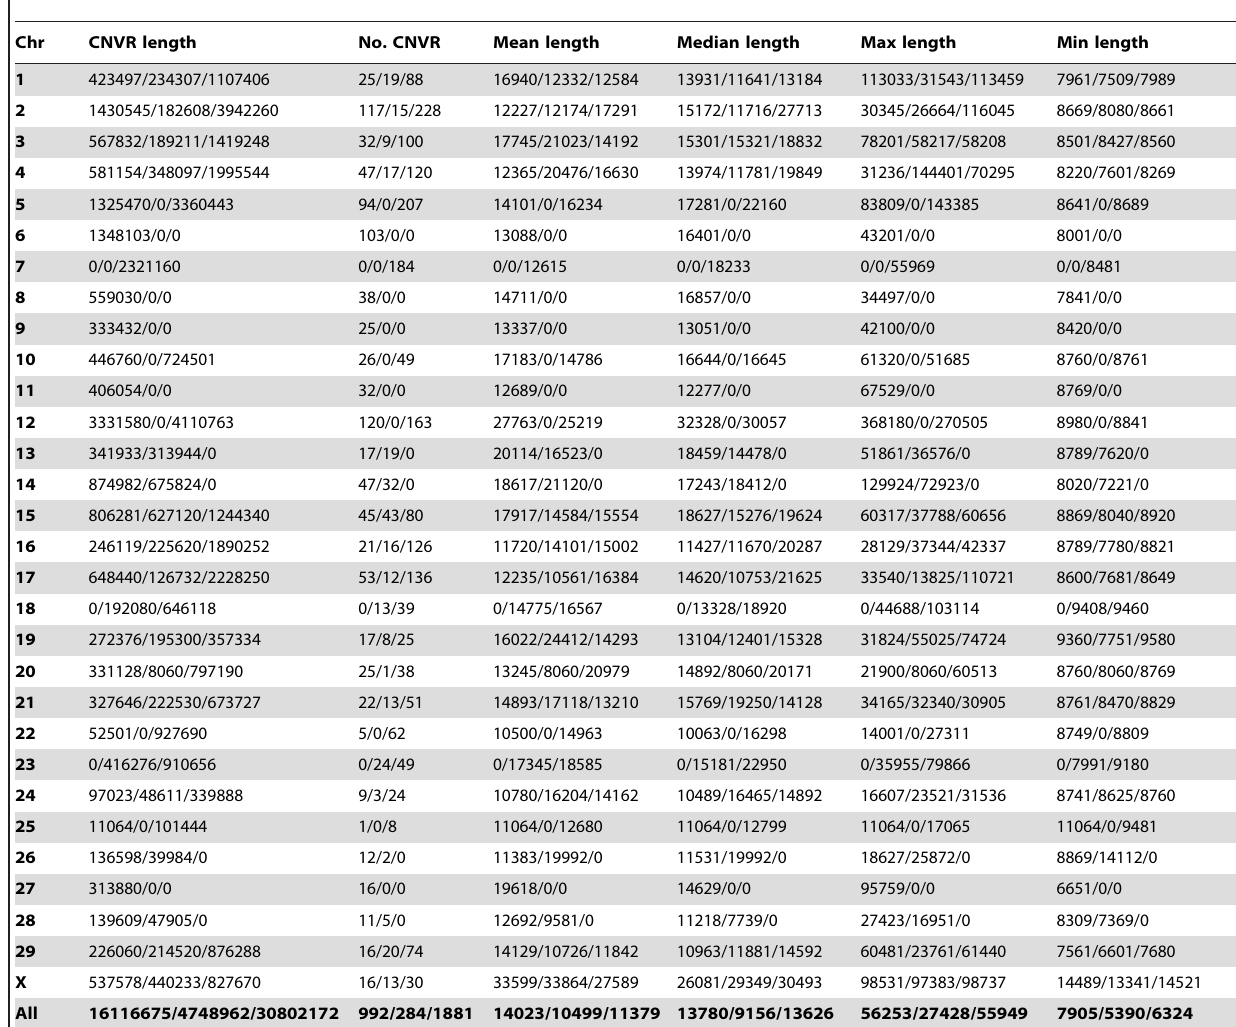
Table 5. Distributions and characteristics of putative copy number variation regions (CNVRs) in genome comparisons of Hanwoo, Jeju Heugu, and Chikso with Korean